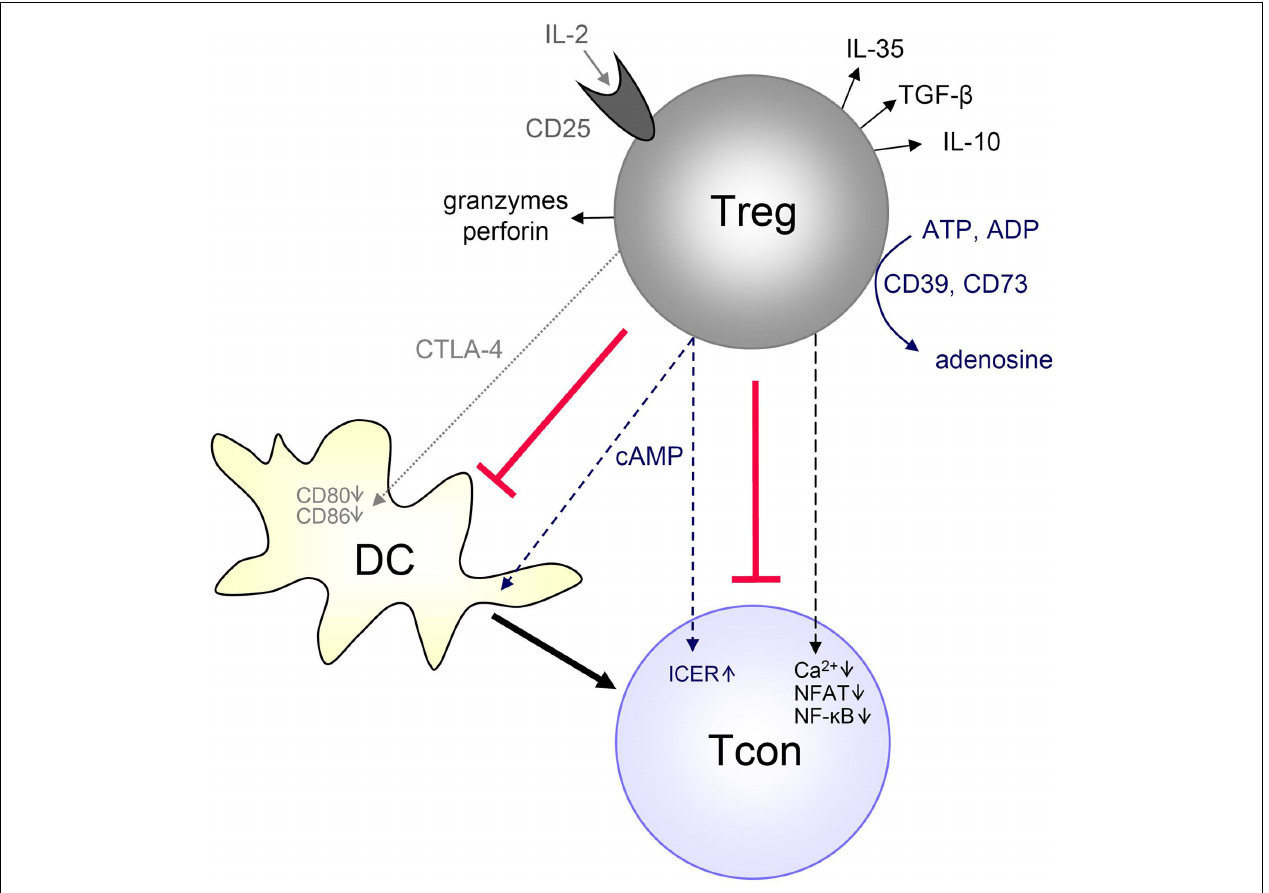
FIGURE 1 | Mechanisms ofTreg-mediatedTcon suppression. Tregs have been described to suppressTcons by different mechanisms, depending on the experimental setup, site and type of immune response.Tregs can generate immunosuppressive adenosine or transfer cAMP toTcons.Tregs can rapidly suppressTCR-induced Ca 2 + , NFAT, and NF- κ B signaling.Tregs can also